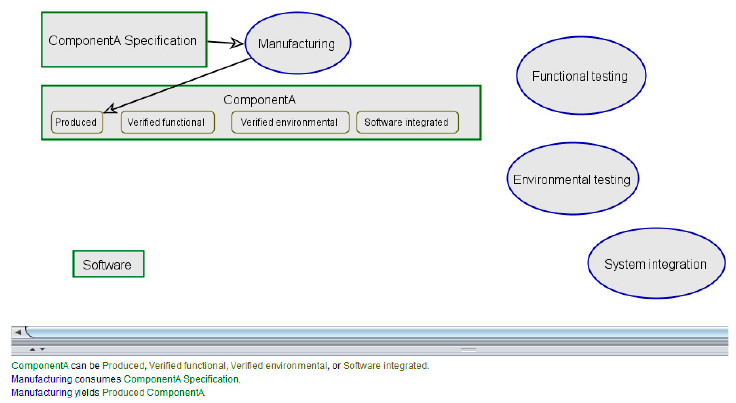
Figure 6. Linking objects and process, option #5.